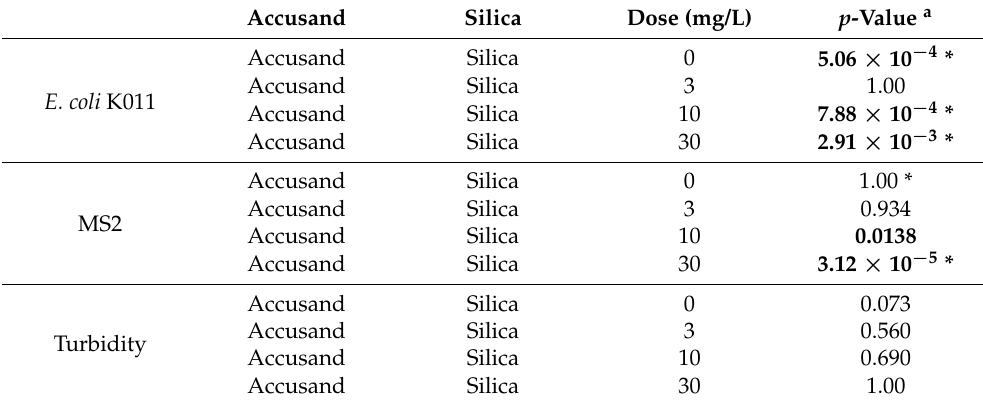
Table 2. Results of the Wilcoxon rank-sum test comparing cumulative median log 10 reduction values of E. coli KO11, MS2, and turbidity by sand type, stratified by dose. Reported p -values were adjusted using the Bonferroni correction, m =